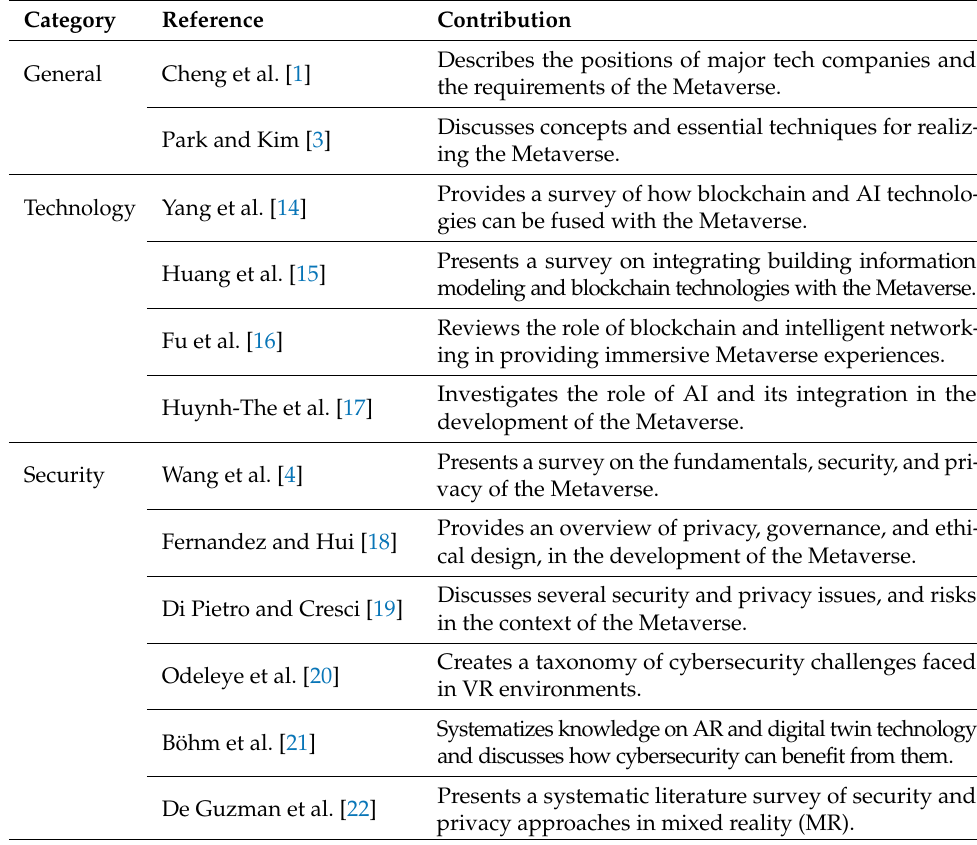
Table 1. Summary of recent surveys on the Metaverse and related